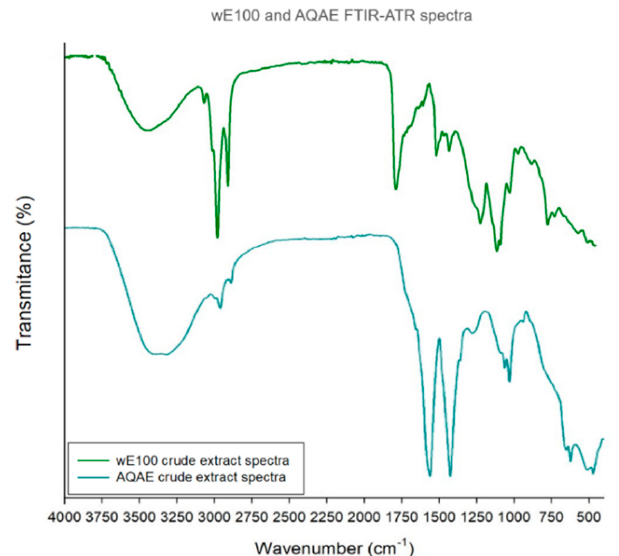
Figure 5. FTIR-ATR spectra of the dry wE100 (green line) and AQAE (cyan line) extracts of Undaria pinnatifida . Table 3. Main bands identified in the FTIR-ATR spectra of the dry wE100 and AQAE extracts of Undaria pinnatifida and potential groups